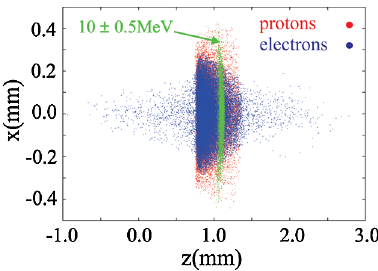
FIG. 8. z - x projection of the particle distributions after 25